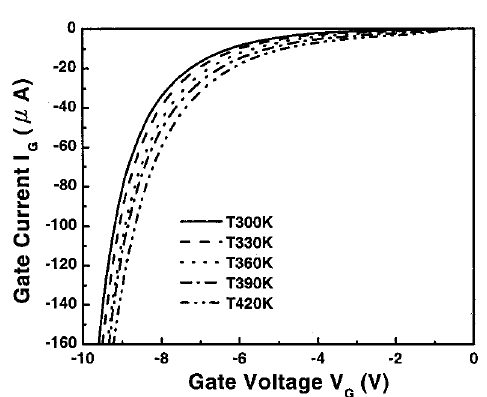
FIGURE 13 The reverse-bias characteristics of gate-to-drain Schottky diode of AlGaAs = InGaAs =